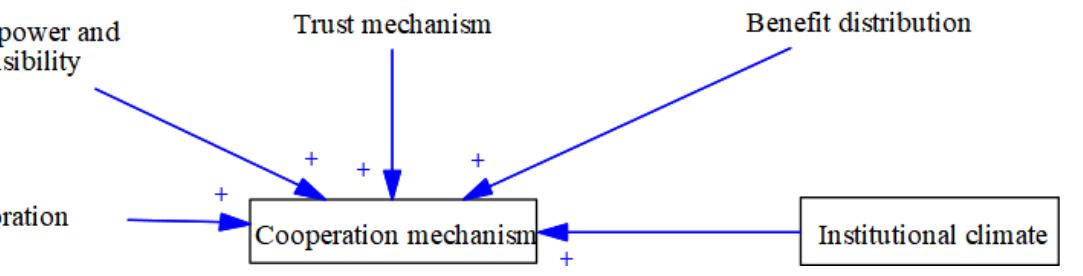
Figure 3. The causal-loop diagram of CM.